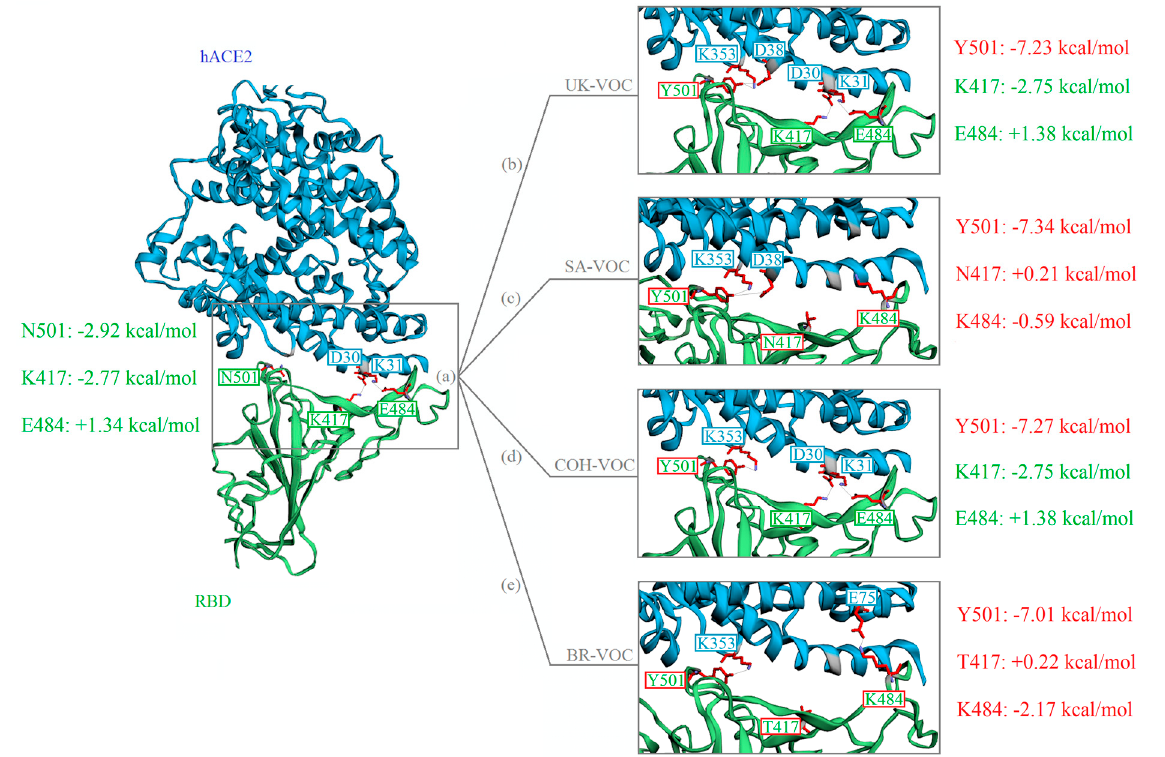
Figure 3. Structure of the SARS-CoV-2 RBD (green) docked with hACE2 (blue). Mutations are shown with red boxes. The contribution of residues to the total FEB (kcal/mol) in the RBD-hACE2 docked complexes for WT ( a ), UK-VOC ( b ), SA-VOC ( c ), COH-VOC ( d ), and BR-VOC ( e ) are computed using MM/GBSA method.